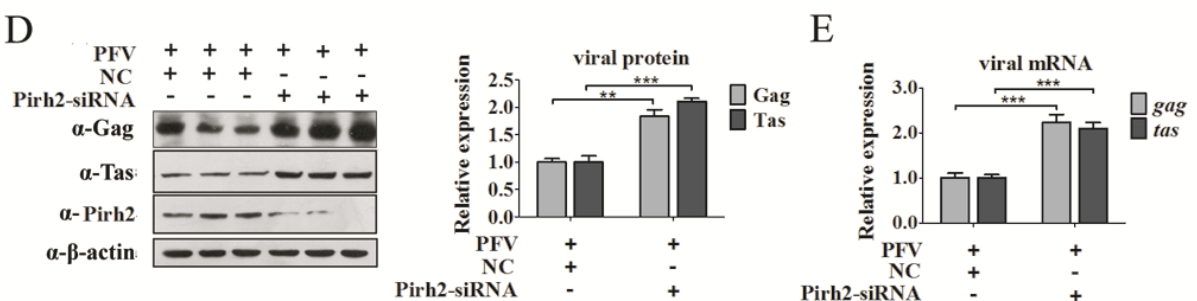
Figure 2. Pirh2 inhibits the replication of PFV. ( A ) The relative viral load in the presence or absence of overexpressed Pirh2 was analyzed using the FAL assay with a PFV indicator cell line. RL-TK (5 μg) was transfected as an internal control; ( B ) 293T cells that seeded in 6-well plate and challenged with PFV (MOI 0.1) were transfected with Flag-Pirh2 (4 μg) or pCMV-Flag (4 μg) (as a control), the level of the viral protein Gag and Tas were analyzed by Western blot with β-actin used as a loading control. Quantitation of Gag and Tas protein levels from the Western blot by using Quantity one software (Bio-Rad); ( C ) 293T cells were seeded in 6-well plate and transfected with Flag-Pirh2 (4 μg) for 24 h (pCMV-Flag (4 μg) was used as a control) and then challenged with PFV for another 48 h. Then, the total RNA (2 μg) was reverse transcribed to cDNA. RT-qPCR was used to examine the relative expression (normalized to β-actin) of the viral structural gene gag and the regulatory gene tas with or without Pirh2 overexpression; ( D ) Specific siRNA used to knockdown Pirh2 (100 pmol) and NC (100 pmol) used as a negative control. The viral protein Gag and Tas was detected by Western blot, quantitation analysis of Gag and Tas intensity from the Western blot by using Quantity one software (Bio-Rad); ( E ) Relative mRNA expression (normalized to β-actin)